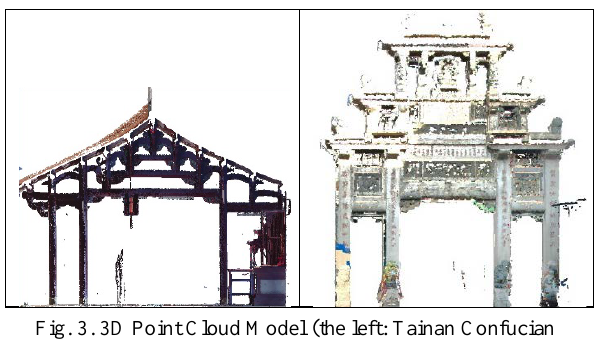
Fig. 3. 3D Point Cloud Model (the left: Tainan Confucian Temple, the right: Qiu Lian-gung's Mother Chastity Arch in Kinmen)